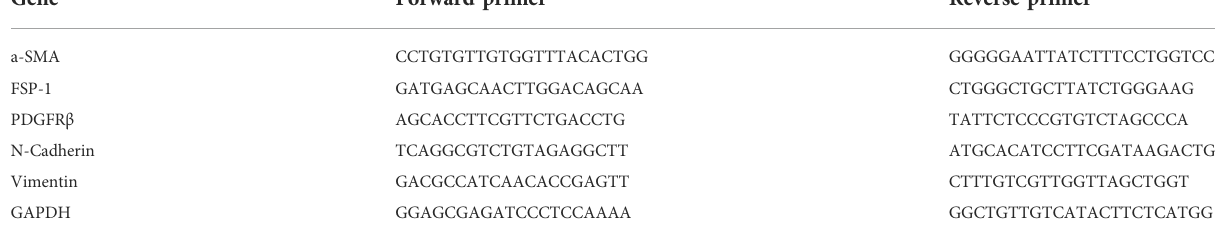
TABLE 1 Primers used for real-time quantitative PCR